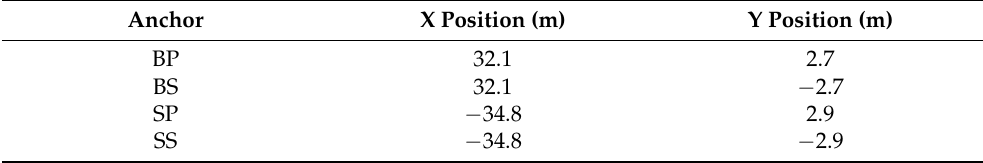
Table 3. Arrangement of anchor winches.